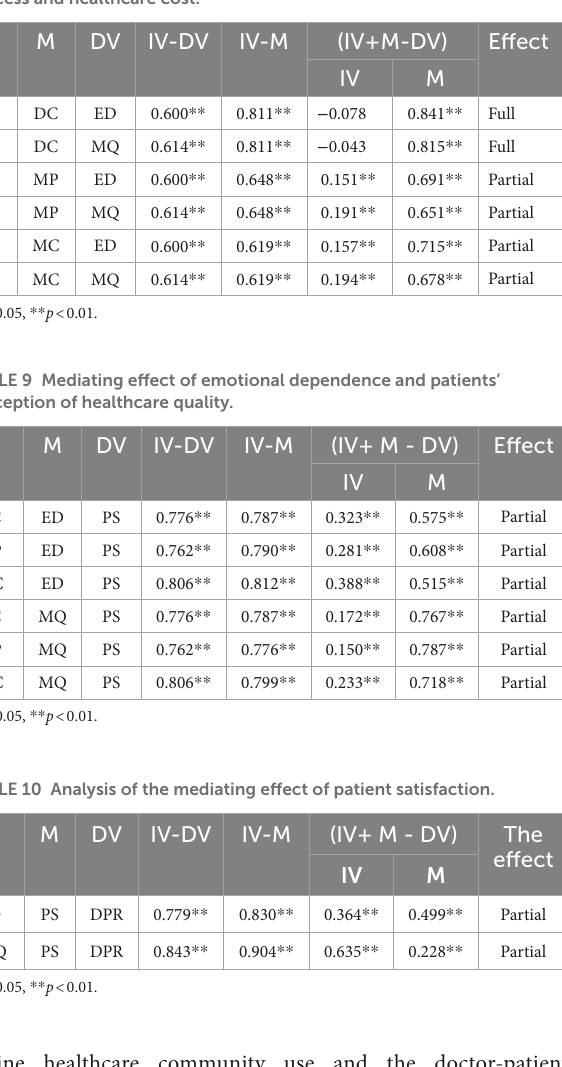
TABLE 8 Mediating effects of doctor-patient communication, healthcare process and healthcare